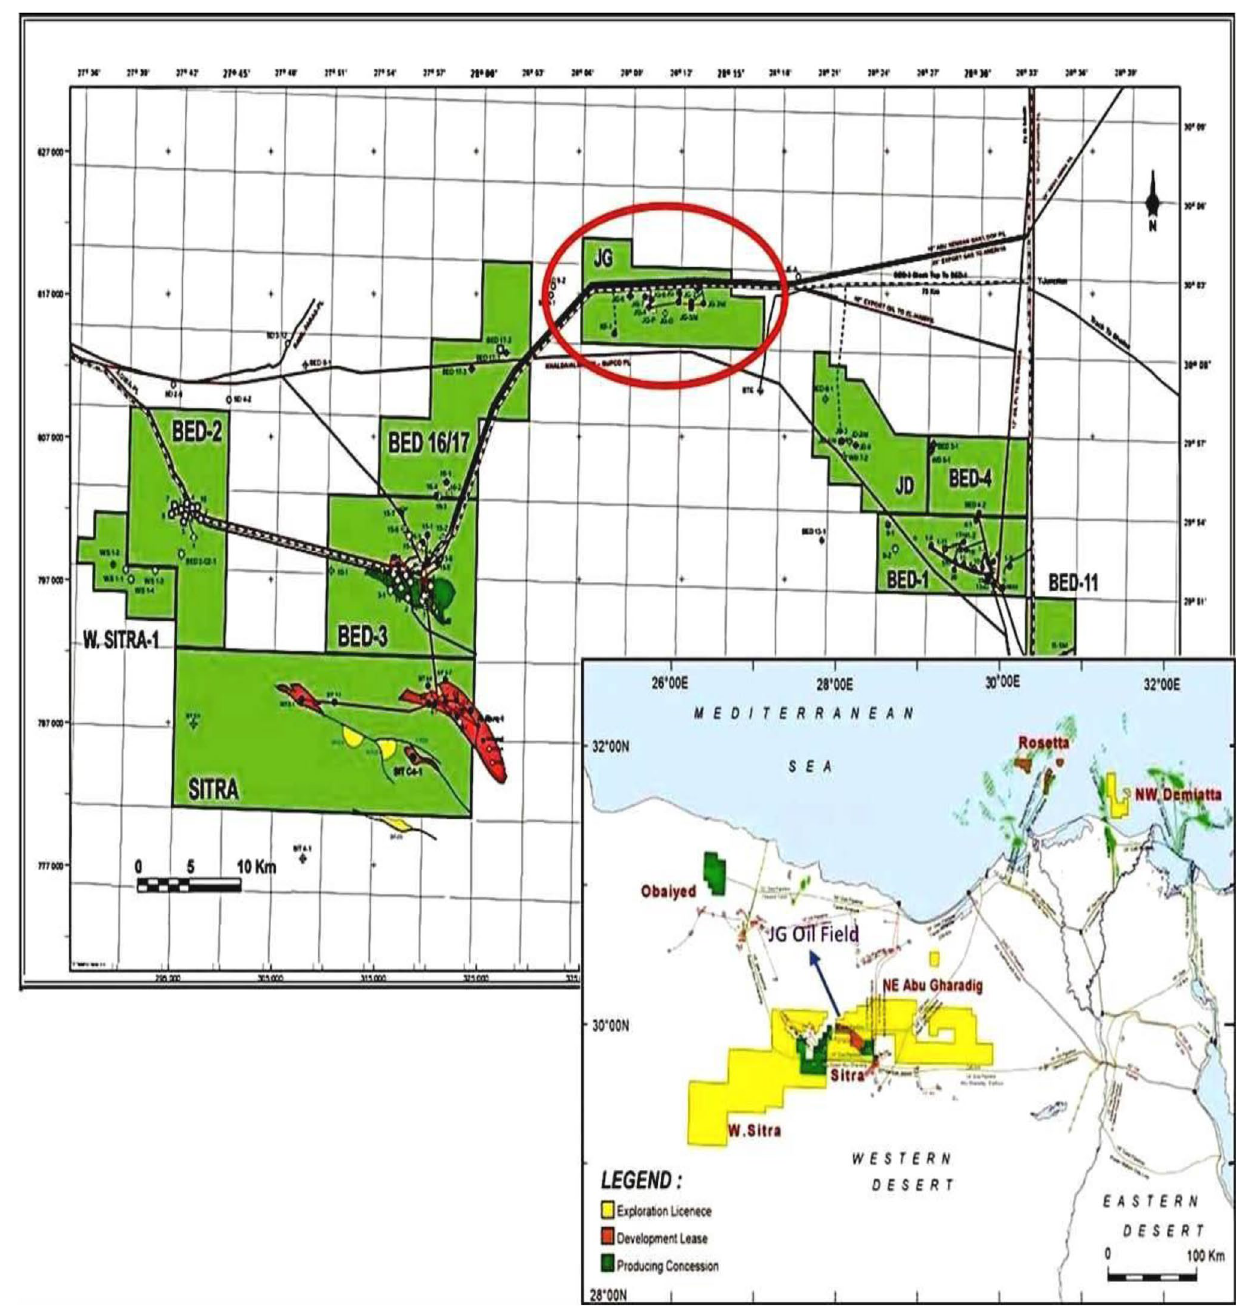
Fig. 1 Location map of JG